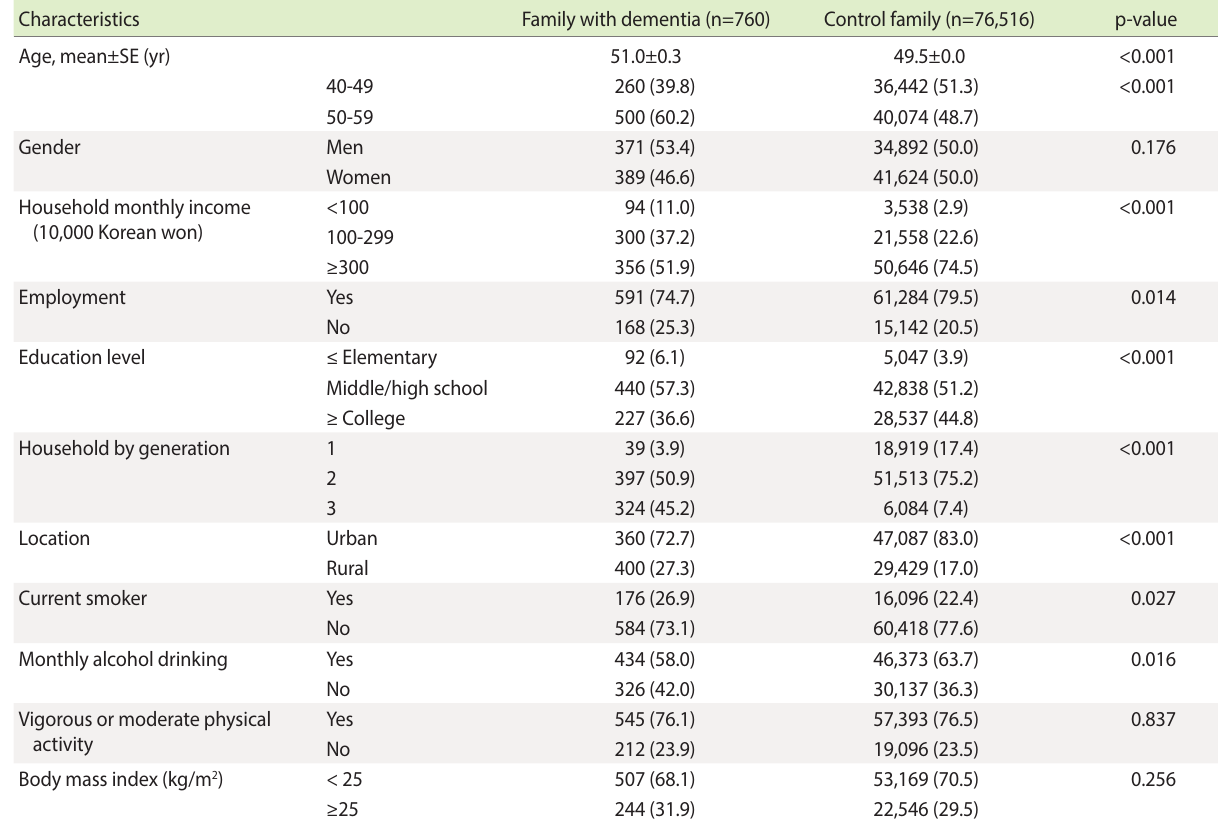
Table 1. General characteristics of the subjects Characteristics Family with dementia (n=760)